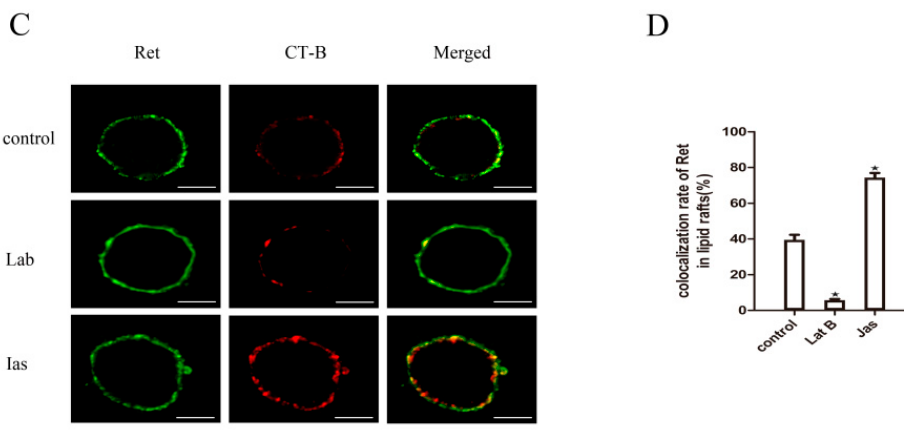
Figure 6. The effects of Lat B and Jas on Ret translocation to lipid rafts. The cells were divided into three groups. The control group was treated with GDNF only for 30 min; the Lat B group and the Jas group were pretreated with Lat B or Jas for 30 min respectively, and then treated with GDNF for 30 min. ( A , B ) The cells were then lysed and subjected to OptiPrep™ density centrifugation. Nine equal fractions were obtained and labeled from 1 to 9. These fractions were analyzed by western blotting for Ret, flotillin-1, and CD71; ( C , D ) Then lipid rafts(red) and Ret(green) patching was induced as described in the methods. Confocal microscopy was used to detect the colocalization of lipid rafts and Ret. The data were represented as means ± SEM of three independent experiments. ★ p < 0.05 vs. control. (Scale bar = 5 μ m).